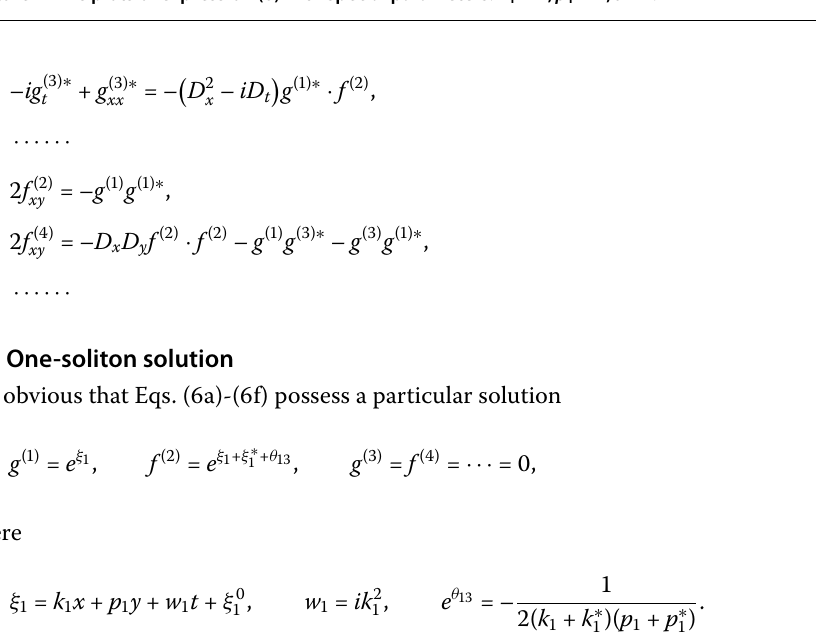
Figure 1 The plots of expression (8) with special parameters: k 1 = 1, p 1 = 2, t =